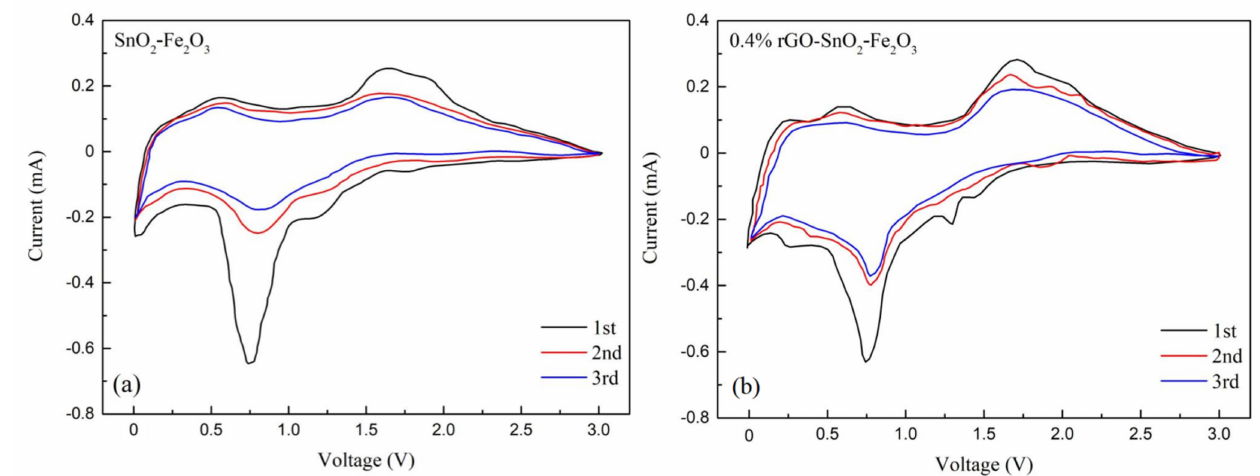
Figure 6. Cyclic voltametric curve. ( a ) 10%SnO 2 -Fe 2 O 3 ; ( b ) 0.4% rGO-10%SnO 2 -Fe 2 O 3 .